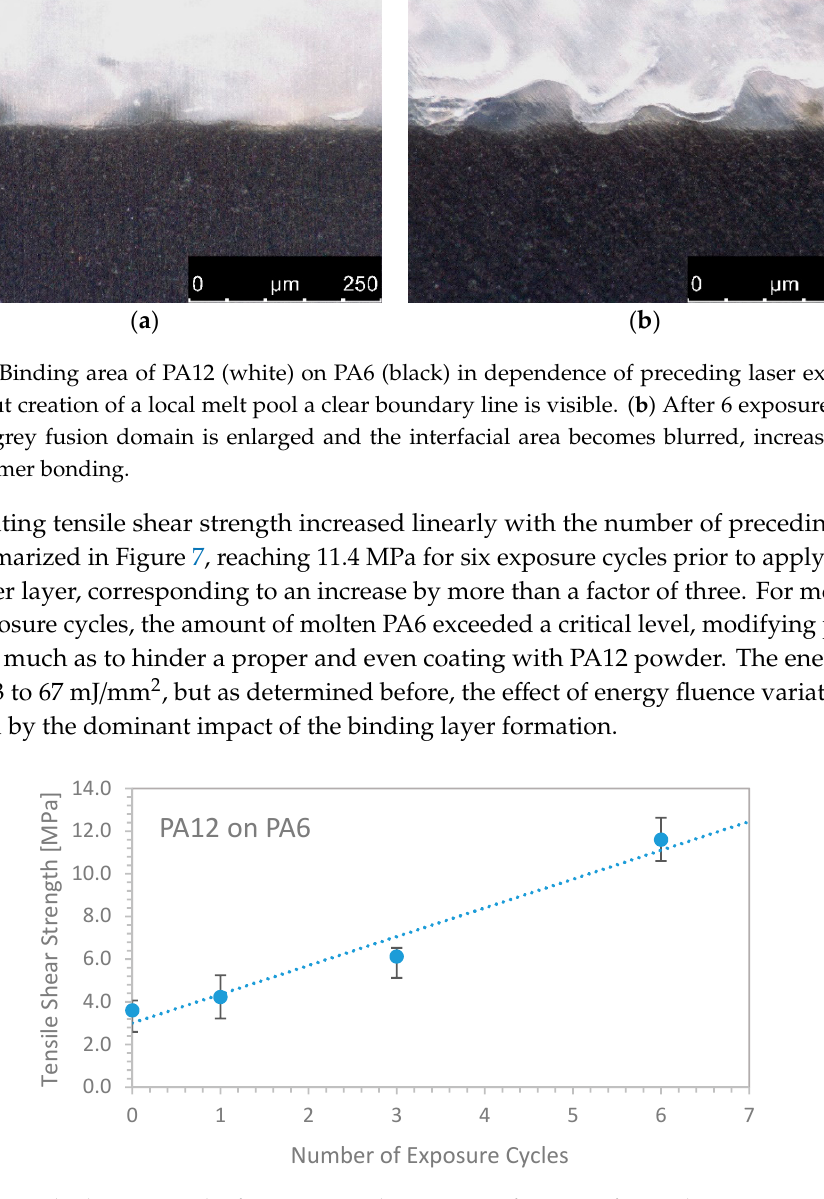
Figure 7. Tensile shear strength of PA12 sintered on PA6 as a function of preceding exposure cycles.